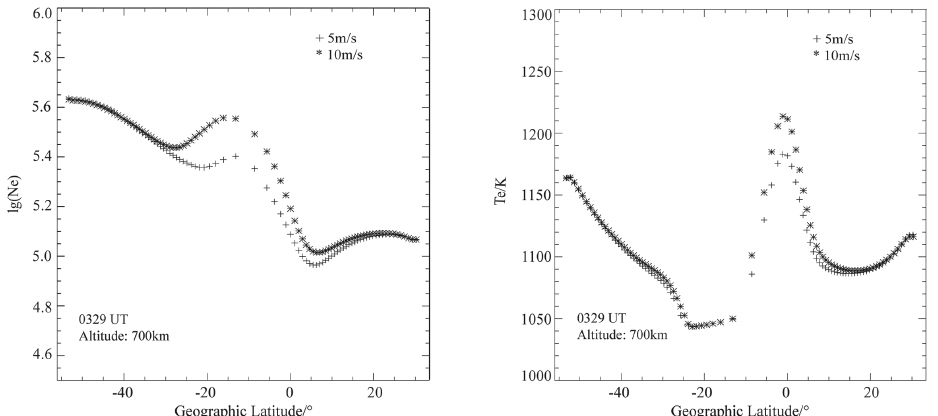
Figure 8. The calculation results from SAMI2 of N e (left) and T e (right) at an altitude of 700km during local nighttime at E × B effects of 5ms − 1 ( + ) and 10ms − 1 (*),